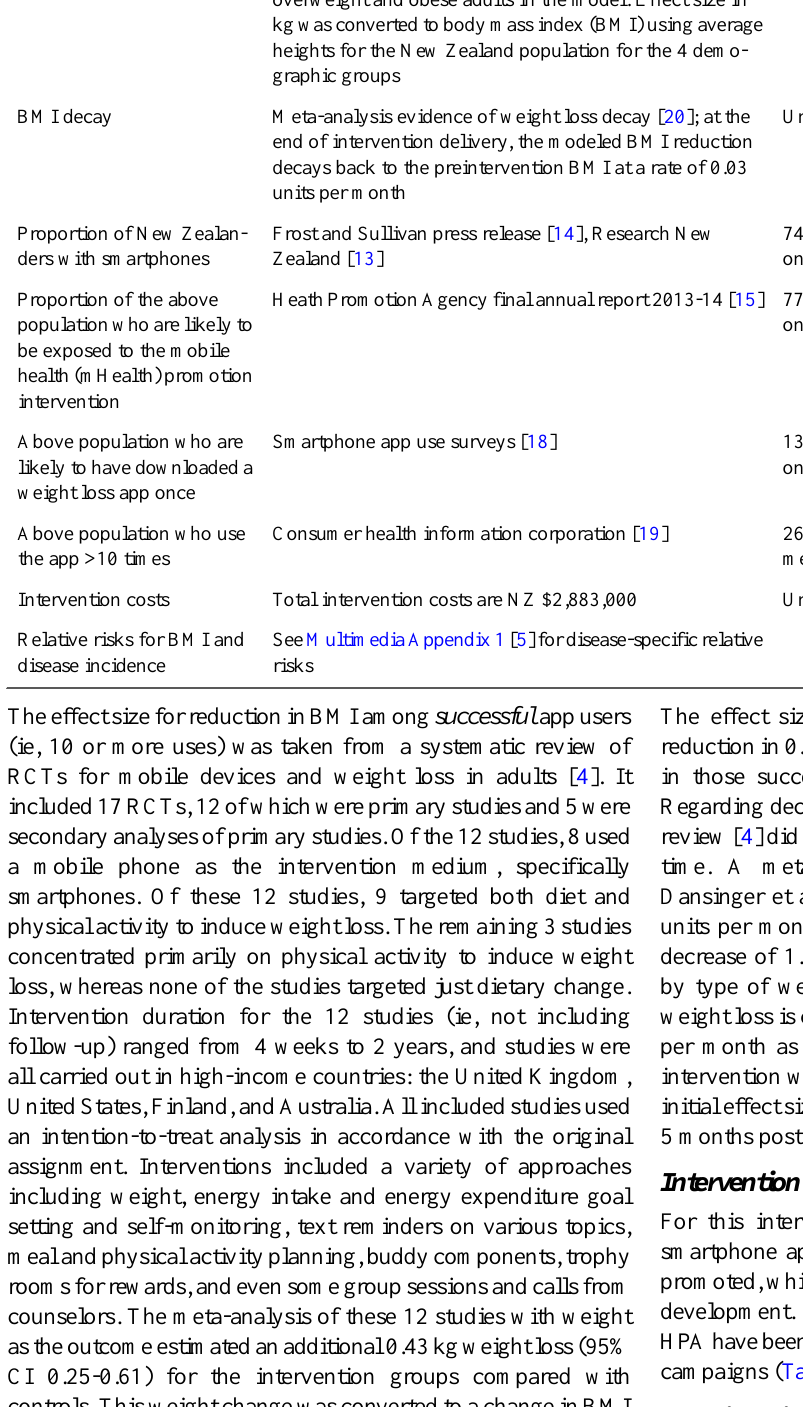
Normal0.43 kg (95% CI 0.25-0.61)The meta-analysis generated an effect size of 0.43 kg